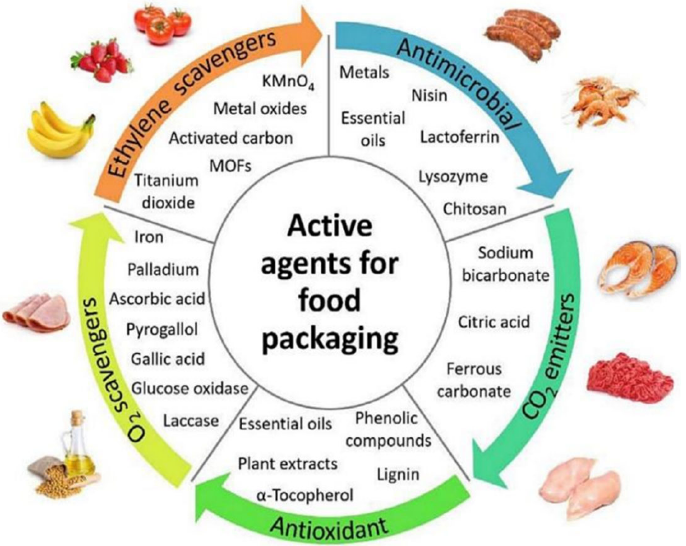
Figure 4. Application of different bioactive compounds in active packaging (reproduced with copyright permission from Vilela et al. [93]).